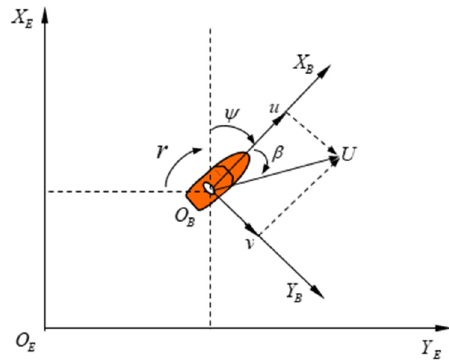
Figure 2. Coordinate systems of